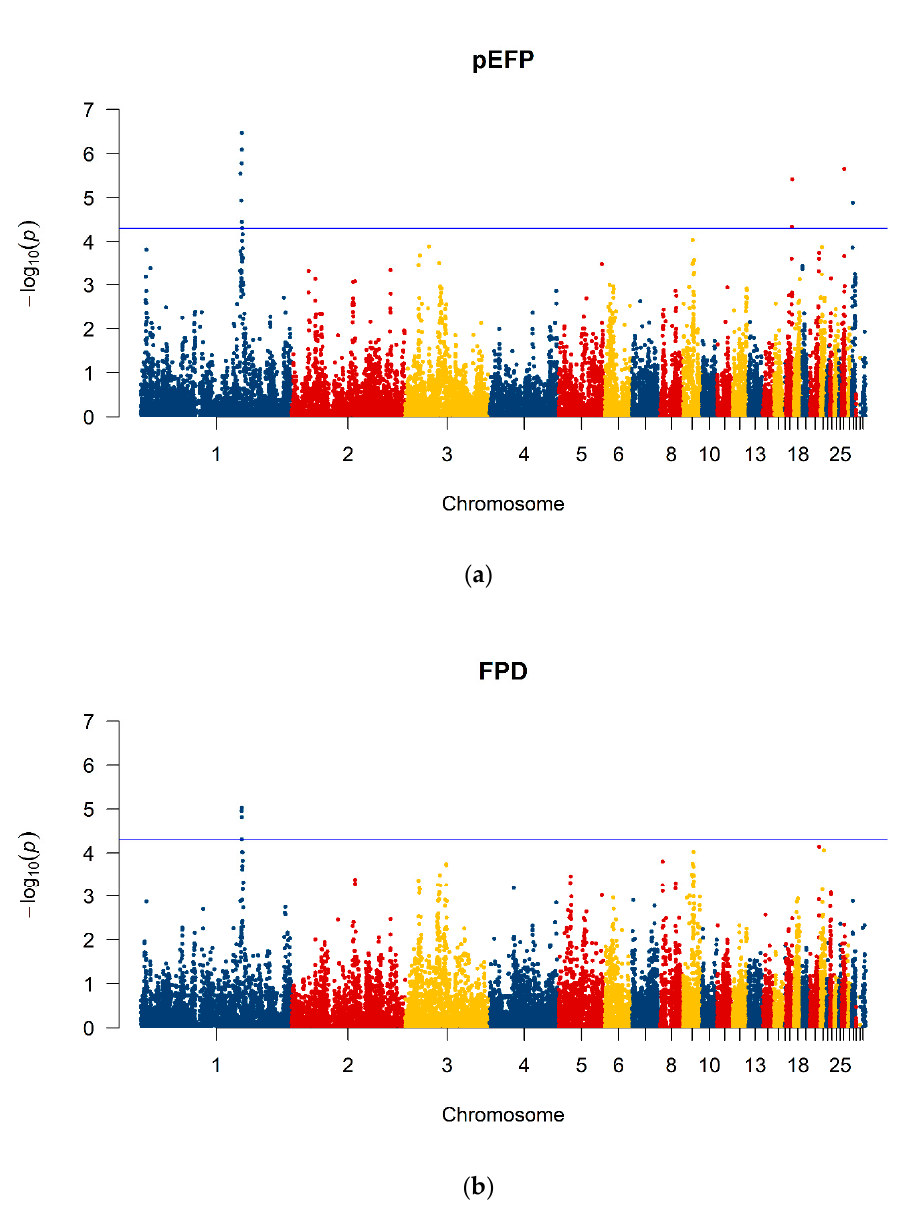
Figure 6. Manhattan plots of the − log 10 p -values for association of SNPs (n SNP = 28,525) for ( a ) the posterior probability of extreme feather pecking (pEFP) and ( b ) feather pecks delivered (FPD). The line indicates the nominal level of significance p ≤ 5 × 10 − 5 .